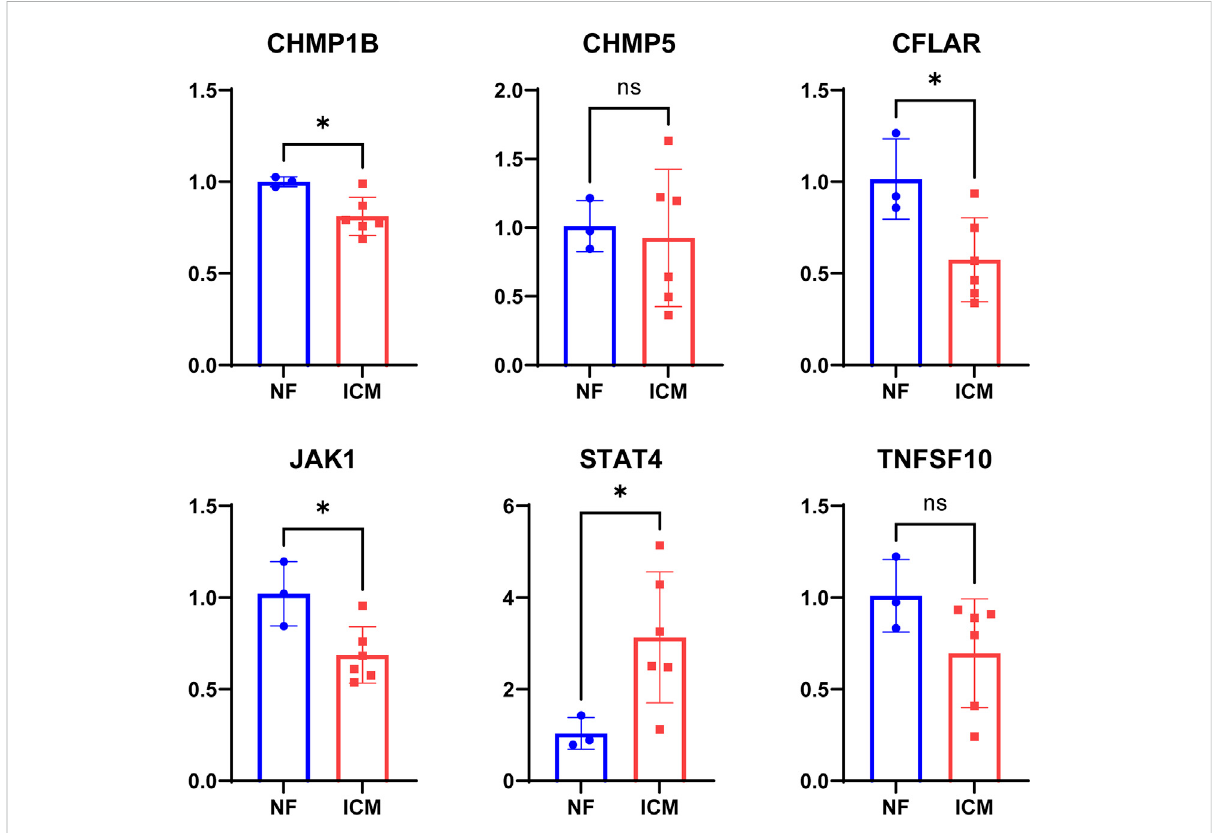
FIGURE 7 The levels of STAT4, TNFSF10, CHMP5, CHMP1B, JAK1, CFLAR mRNA expression in myocardium tissue from non-failing (NF) donor and ICM